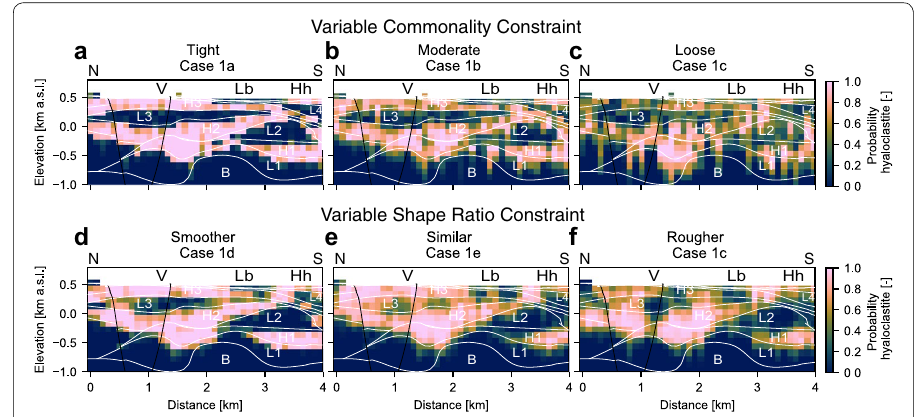
Fig. 6 Prior-only test investigating effect of commonality constraint and shape ratio constraint (Case 1). Prior probability of hyaloclastite for a tight (Case 1a), b moderate (Case 1b), and c loose (Case 1c) commonality constraint. Bottom show shows prior probability of hyaloclastite for d smoother (Case 1d), e similar (Case 1e), and f rougher (Case 1f) shape ratio constraint. Results are plotted along Section 1